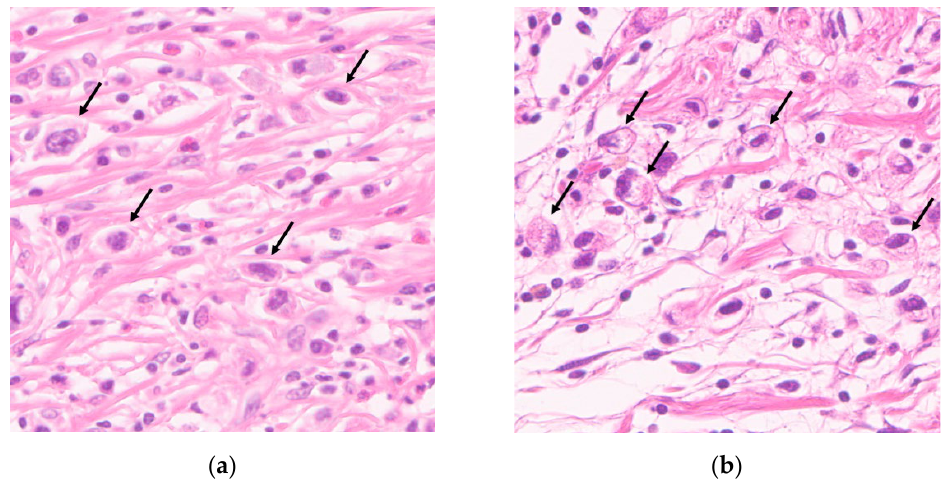
Figure 1. Representative histopathological images of tumor budding (magnification ×400). ( a ) Hematoxylin and eosin staining of a tumor section showing tumor budding morphologically consistent with poorly cohesive carcinoma not otherwise specified and ( b ) signet ring cell carcinoma.